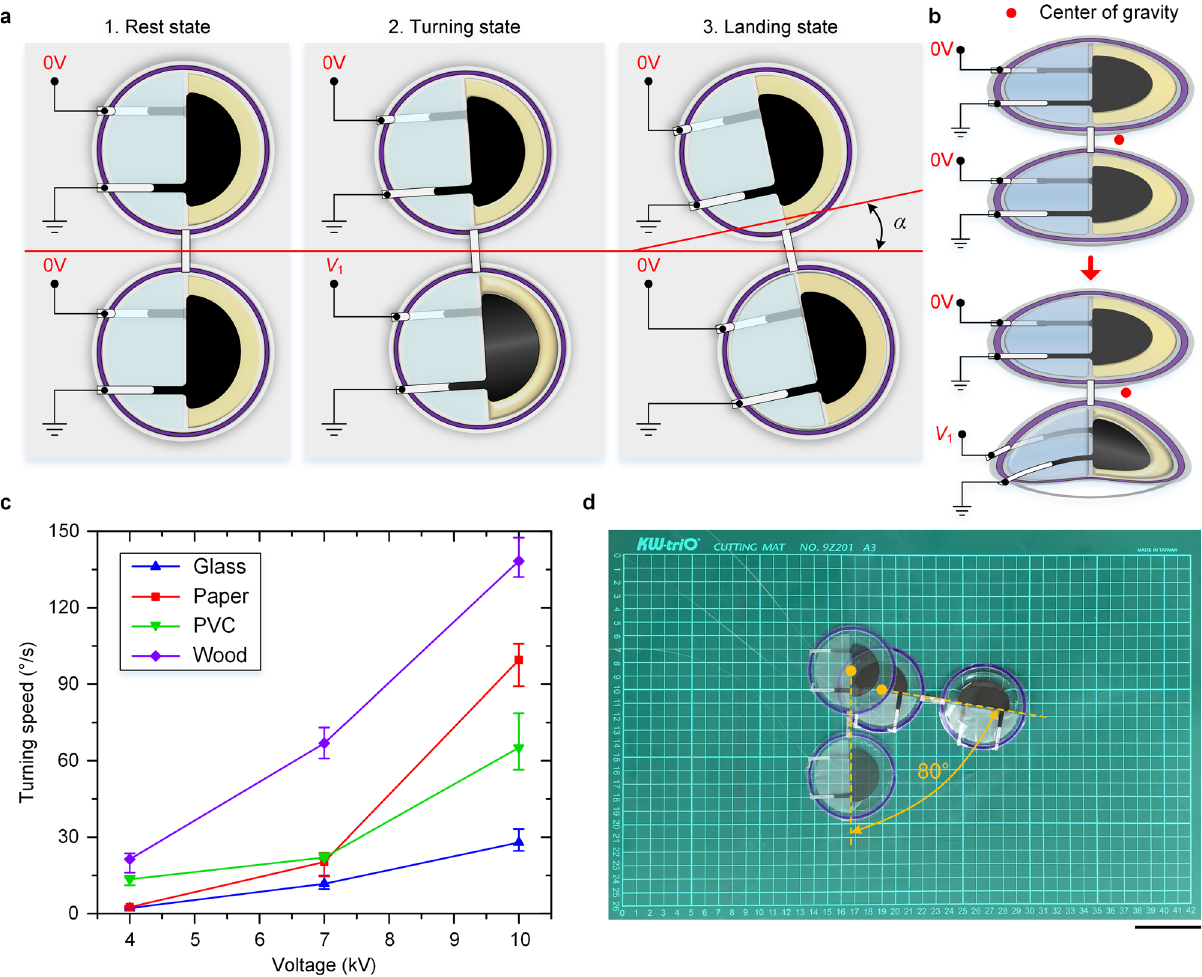
Fig. 4 Turning results of the dual-body LSJR. See also Supplementary Movie 4. a Schematic diagram of the dual-body LSJR turning process, which consists of the rest state, the turning state, and the landing state. Over each voltage cycle, the robot turns by an angle of α . b Center of gravity of the dual- body LSJR. c The relationship between TS and applied voltage on the four substrates. d Composite image of the initial and fi nal positions during a continuous turning procedure on the PVC plate with a speed of 65.0°/s. The robot took 1.23 s to turn 80° at 10 kV and 4 Hz. Scale bar, 5